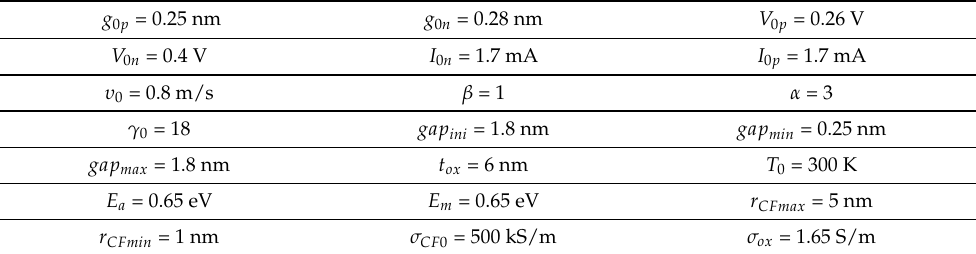
Table 5. Fitting parameters for the UGR-VCMTCF